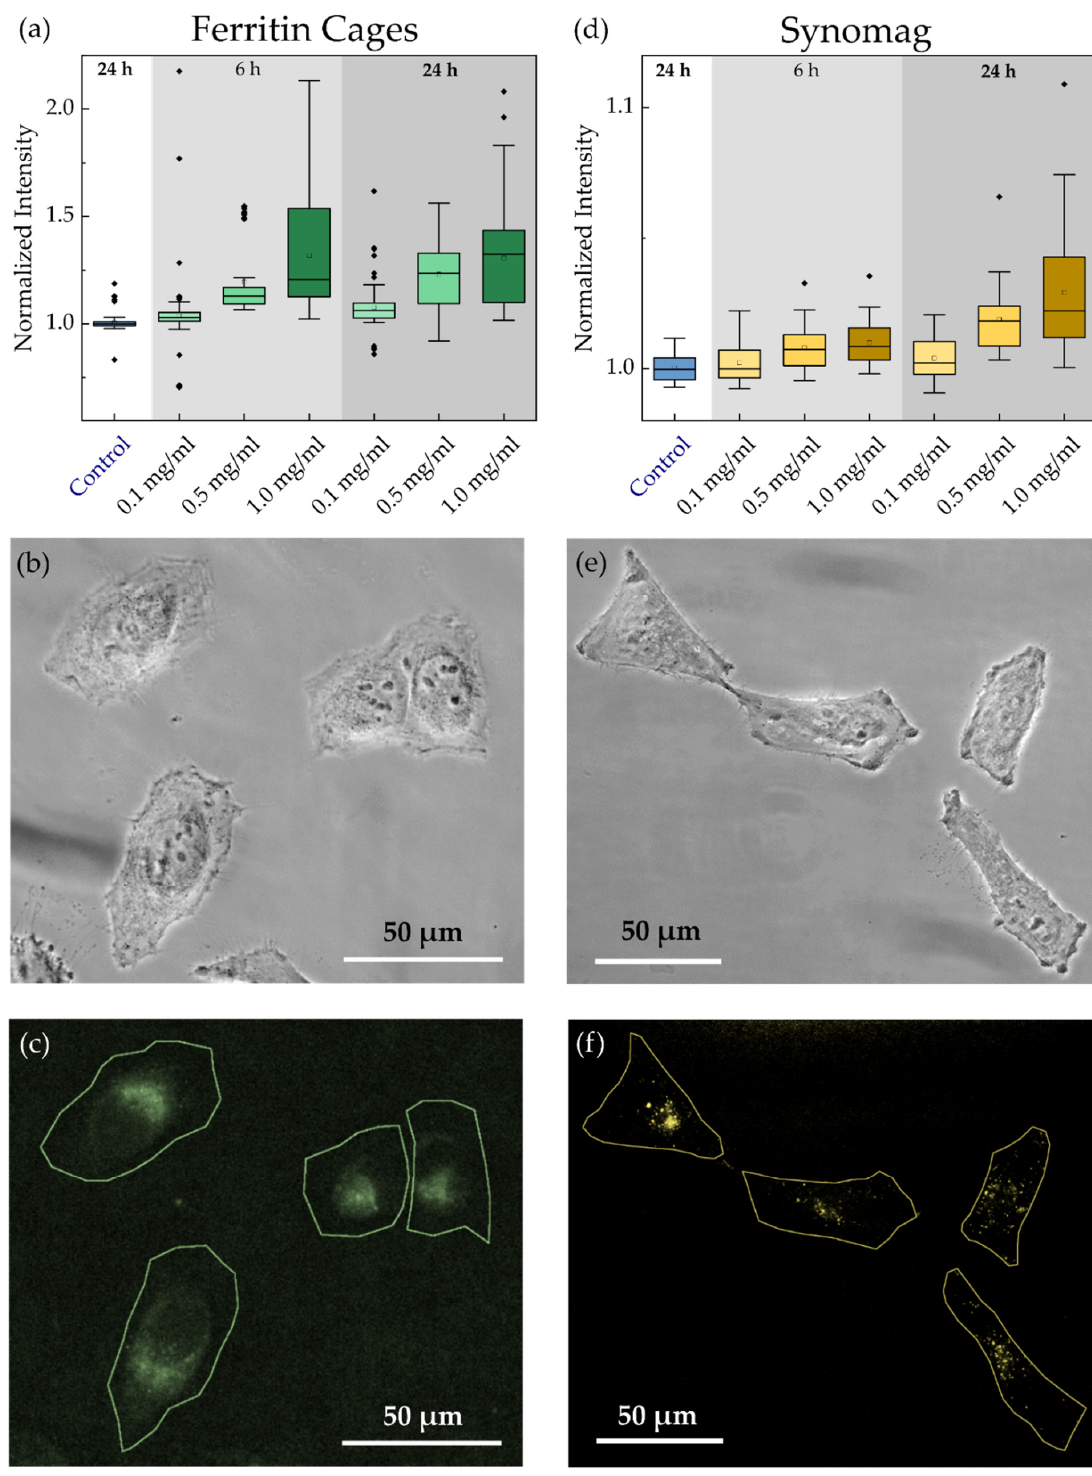
Figure 4. Normalized HeLa WT cellular uptake of ( a ) ferritin cages and ( d ) synomag nanoparticles (NH 2 surface) as function of concentration. Intensity is given as intensity per pixel inside the cell. Particle systems were transferred into the cells via incubation for 6 or 24 h. ( b , c ) Phase contrast image and corresponding fluorescent image with cell outlines recorded using 470/525 nm filter for ferritin cages. ( e , f ) Phase contrast image and corresponding fluorescent image with cell outlines recorded using 545/620 nm filter for synomag NPs. Box plots show the distribution of 100–260 cells recorded in each of five independent measurements per